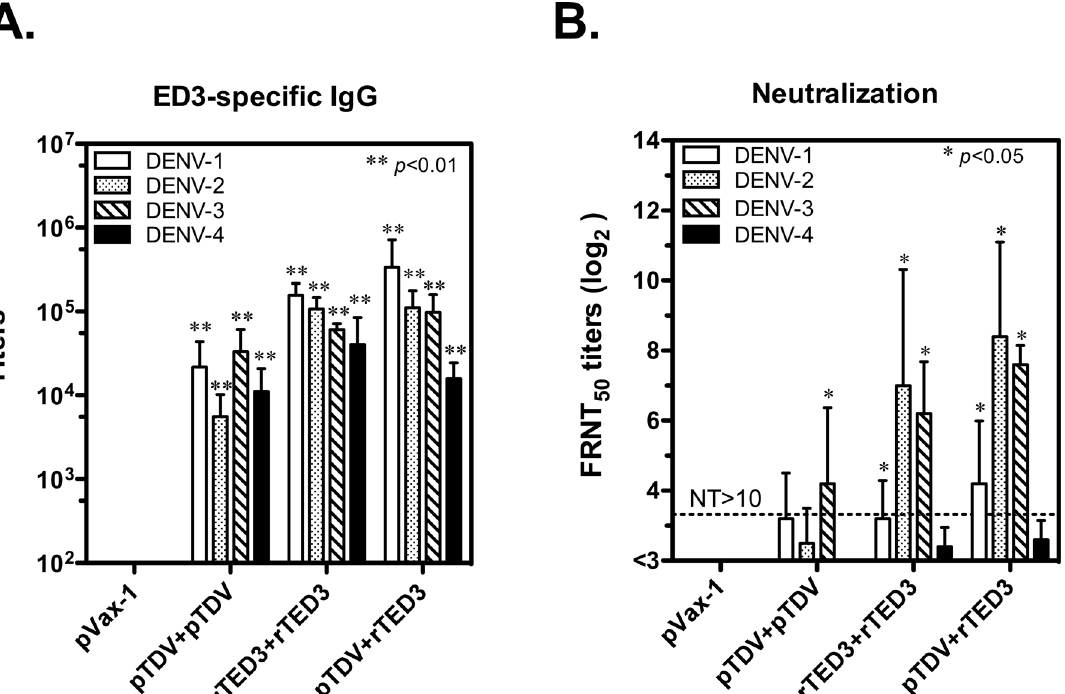
Fig 3. ED3-specific antibody responses elicited by tetravalent dengue vaccines. Groups of 6- to 8-week-old BALB/c female mice (n = 6) were immunized three times at 2-week intervals with pVax-1, pTDV-ED3, rTED3 or prime-boost as the same schedule in Fig 2. The results showing here come from the sera sample collected at week 6 after immunization. (A) The ED3-specific IgG titers assayed by ELISA is presented with the mean and SD. (B) The neutralizing antibody titers against four serotypes of DENV were determined by FRNT, and the endpoint titer leading to (cid:1) 50% reduction (FRNT 50 ) is shown. Mann-Whitney t-tests were used for statistical analyses, and the significance compared to the pVax-1 group is shown, if nothing else is indicated. The data are representative of two independent experiments with similar results.